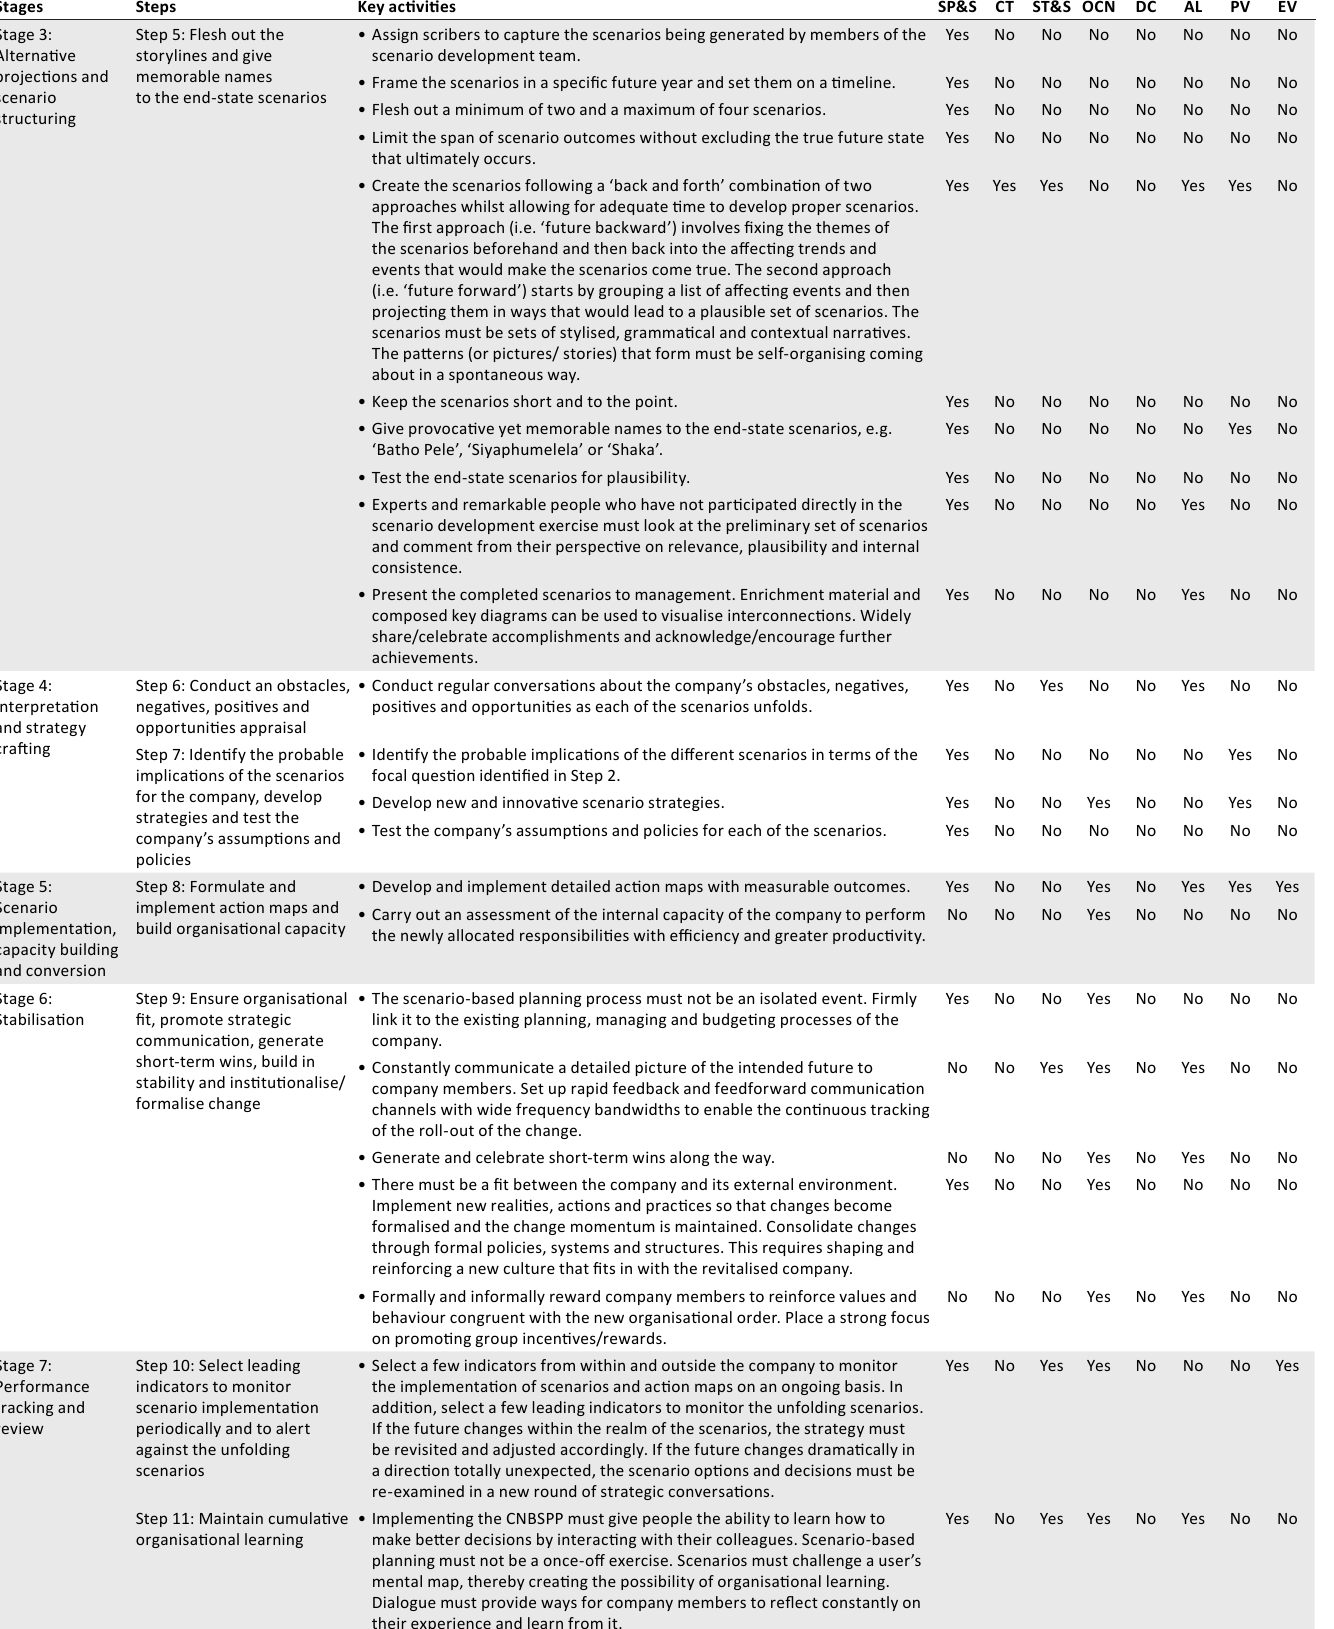
TABLE 1 (Continues...): A contextually aligned and empirically validated CNBSPP applicable to a developing country from an Afro-centric leadership